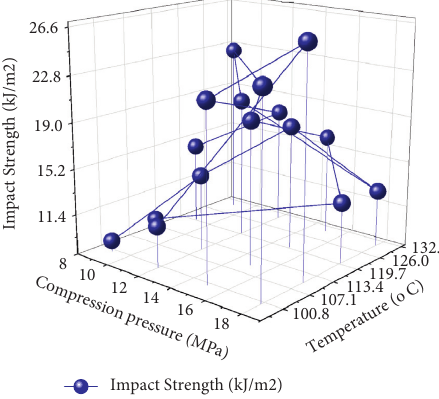
Figure 17: Impact strength: 3D trajectory plot compression pressure.